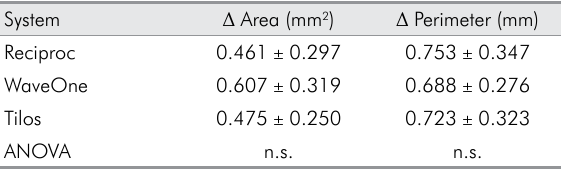
Table 1. Mean differences between the initial and final area and perimeter.